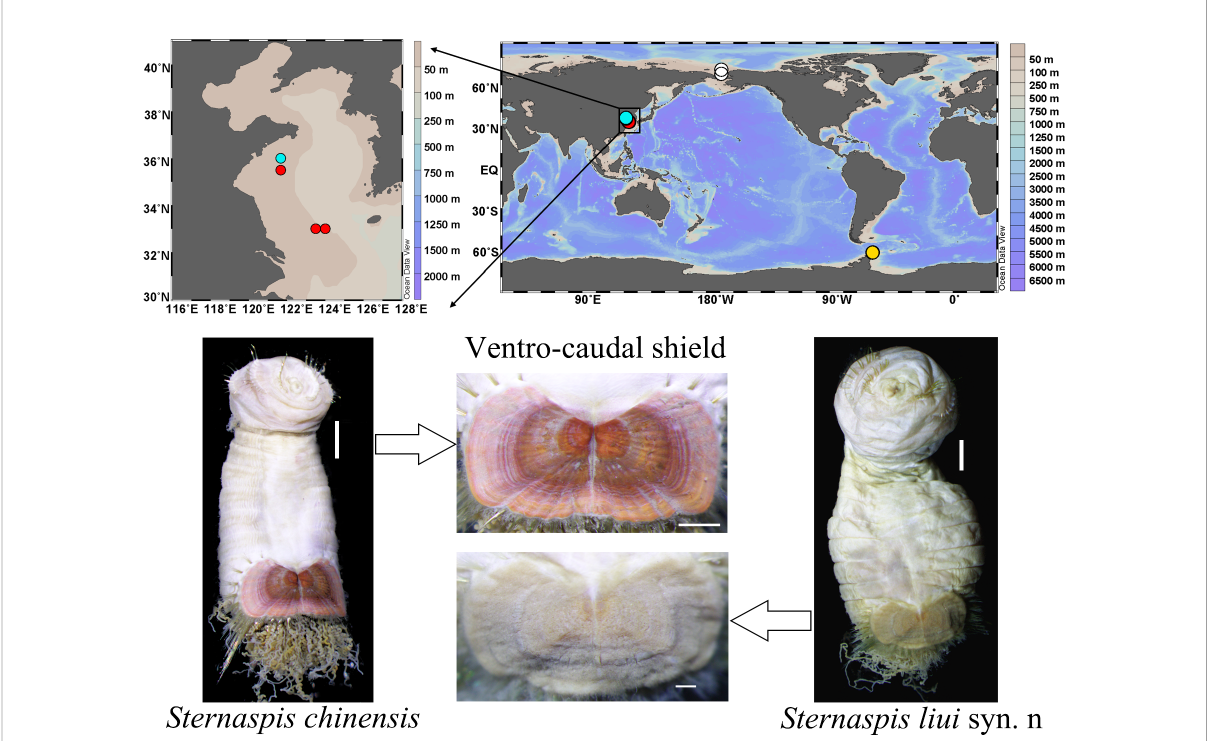
FIGURE 1 Sampling locations of sternaspid specimens used in the present study and morphological images of two sternaspids from the China Seas. Red circle, Sternaspis chinensis ; cyan circle, Sternaspis liui syn. n; white circle, Sternaspis buzhinkajae ; yellow circle, Sternaspis sendalli . Scale bars: S. chinensis body = 2 mm, shield = 1 mm; S. liui syn. n body = 2 mm, shield = 500